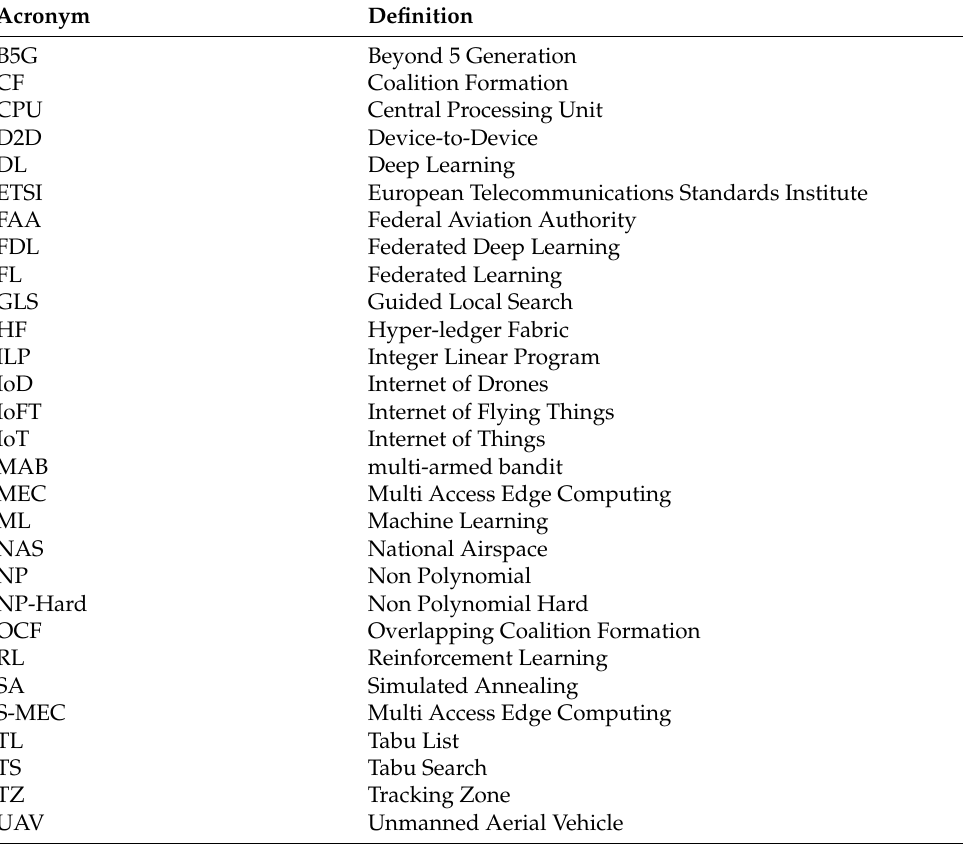
Table 1. Acronyms